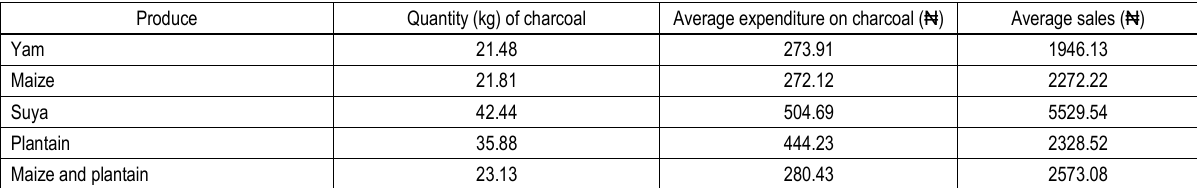
Table 3. Average quantity (kg) of charcoal utilized, expenditure on charcoal and sales revenue of traders